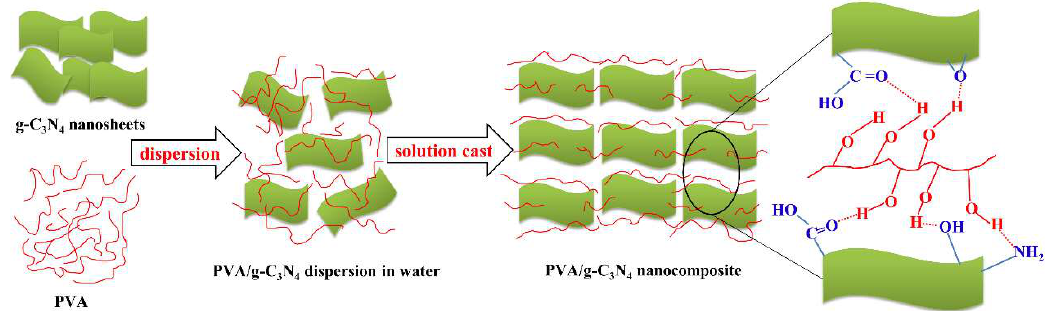
Figure 2. Schematic illustration of nanocomposite preparation and the interaction between g-C 3 N 4 nanosheets and poly(vinyl alcohol (PVA).